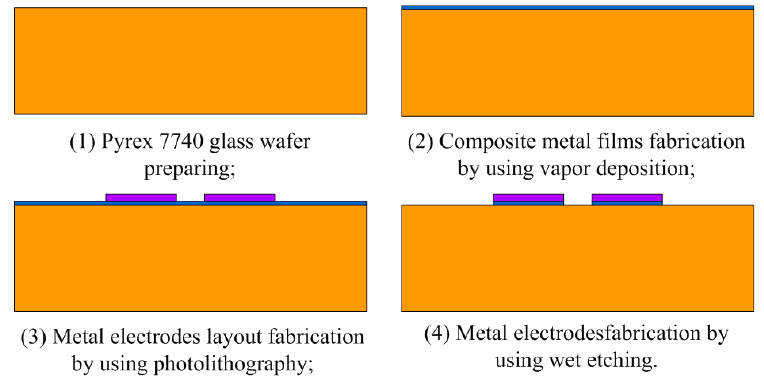
Figure 3. MEMS technological processes for glass-base.